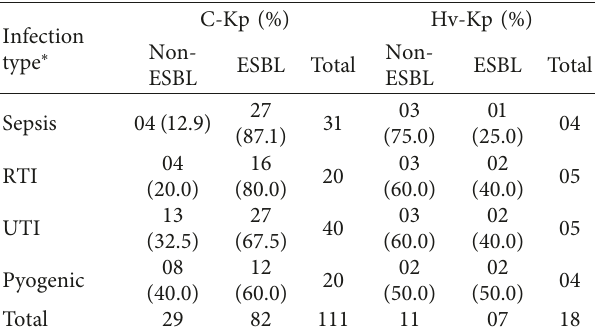
Figure 1: Gel image of detection and amplification (by polymerase chain reaction) of aerobactin gene (556 bp) in Klebsiella pneu- moniae isolates included in the study. NCE: negative control of extraction, NTC: nontemplate control Hv- K. pneumoniae : hy- pervirulent Klebsiella pneumoniae, C- K. pneumoniae : classical Klebsiella pneumoniae, ESBL+: extended spectrum of beta lacta- mases positive, MDR: multidrug resistant. Table 8: Infections caused by classical and Hv-Kp.